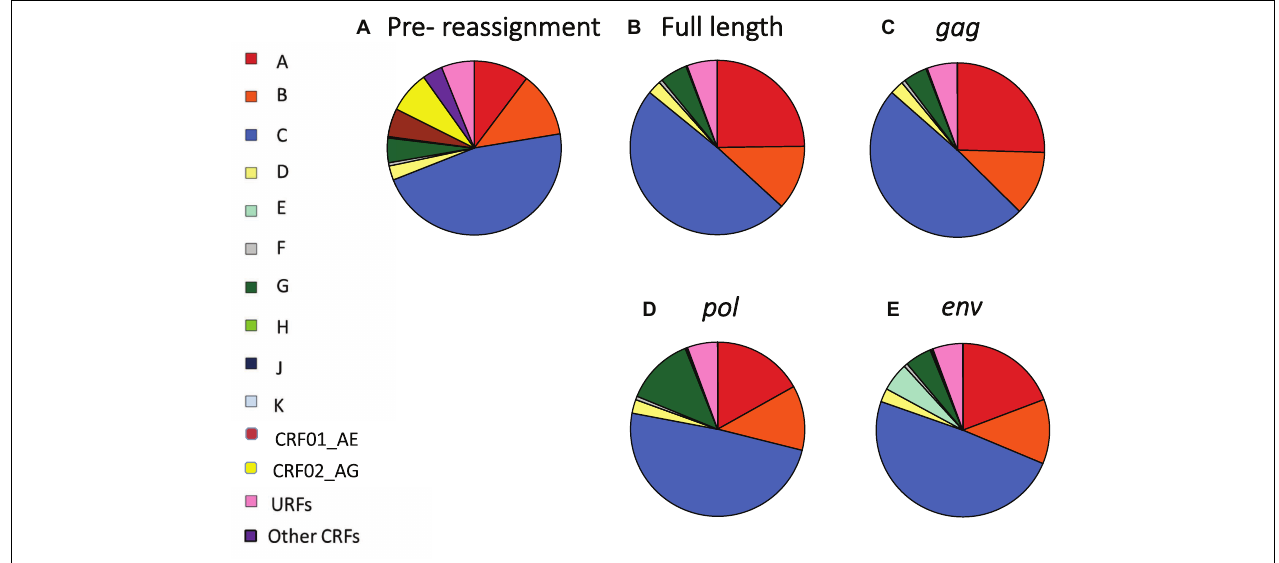
FIGURE 1 | Global distribution of HIV-1 variants before and after reassignment of CRFs to “pure” HIV-1 subtypes. (A) Global proportions of HIV-1 subtypes A–K, CRF01_AE, CRF02_AG, other CRFs and URFs, based on most recent data available for each country. (B–E) Global proportions of HIV-1 variants after reassignment of CRFs to “pure” HIV-1 subtypes, based on full-length sequence (B) , gag (C) , pol (D) , and env (E) . CRF, circulating recombinant form; URF, unique recombinant form. Data underlying this figure is displayed in Supplementary Material , pp.